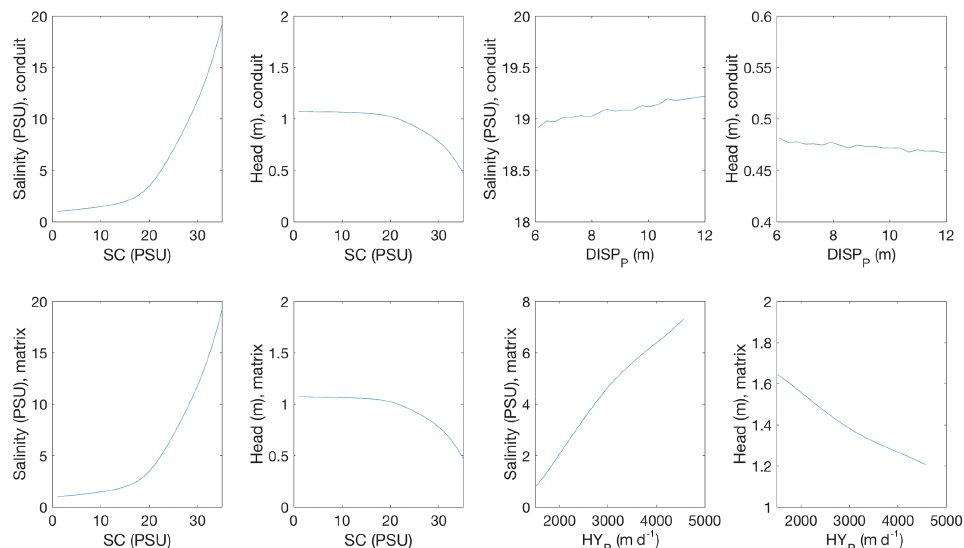
Figure 9. The nonlinear relationship between head and salinity simulations with respect to parameters SC, DISP_P, and HY_P. (Note that the scale for each plot is